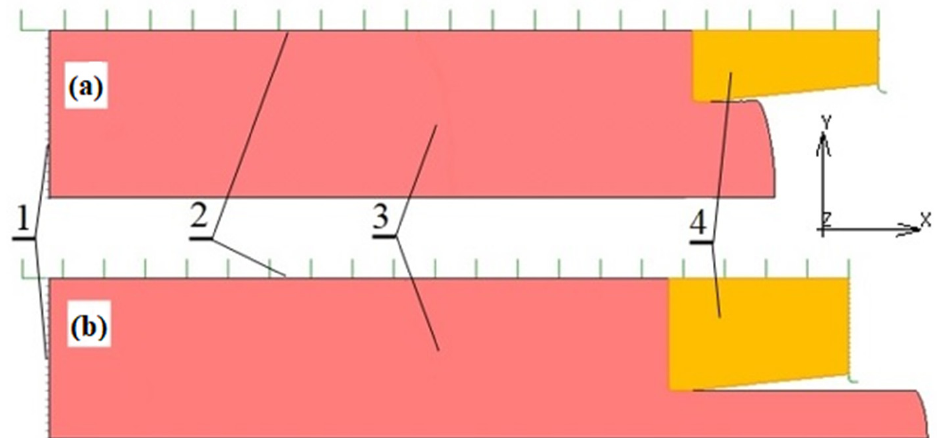
Figure 3. Axisymmetric geometrical model of the FEM simulation of extrusion process: ( a ) R = 3, ( b ) R = 11 (1—punch, 2—container, 3—billet, 4—die).